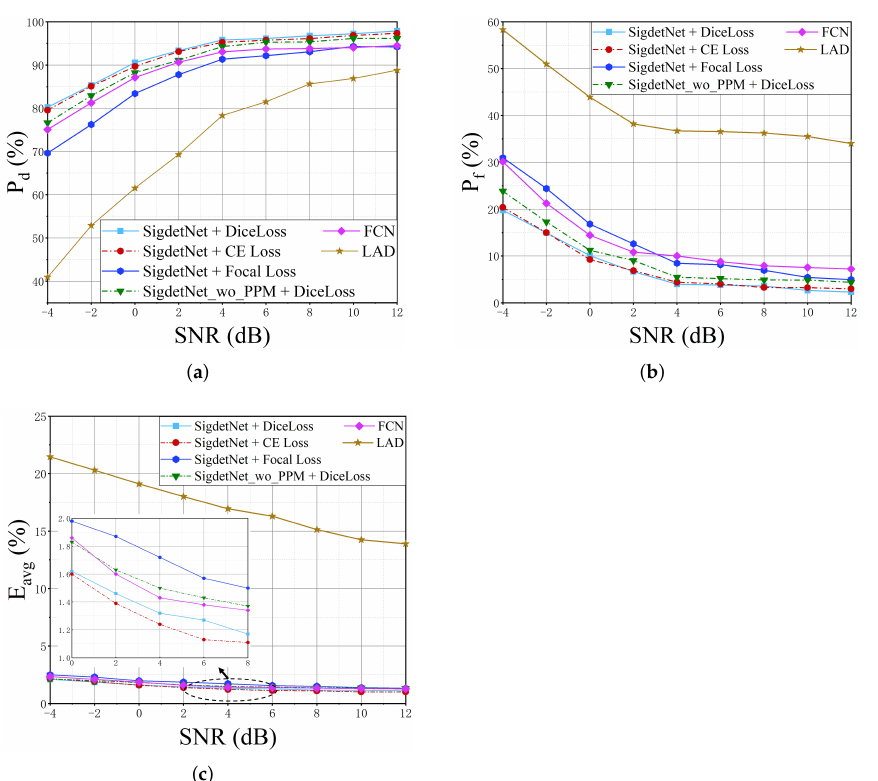
Figure 11. Performance comparison with existing methods. ( a ) detection probability comparison results; ( b ) false alarm probability comparison results; ( c ) comparison results of mean absolute error of parameter